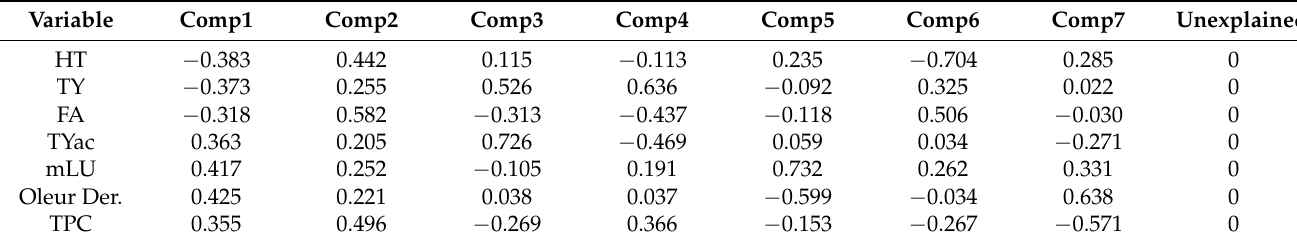
Table 6. Component loadings of the biophenols of EVOOs.